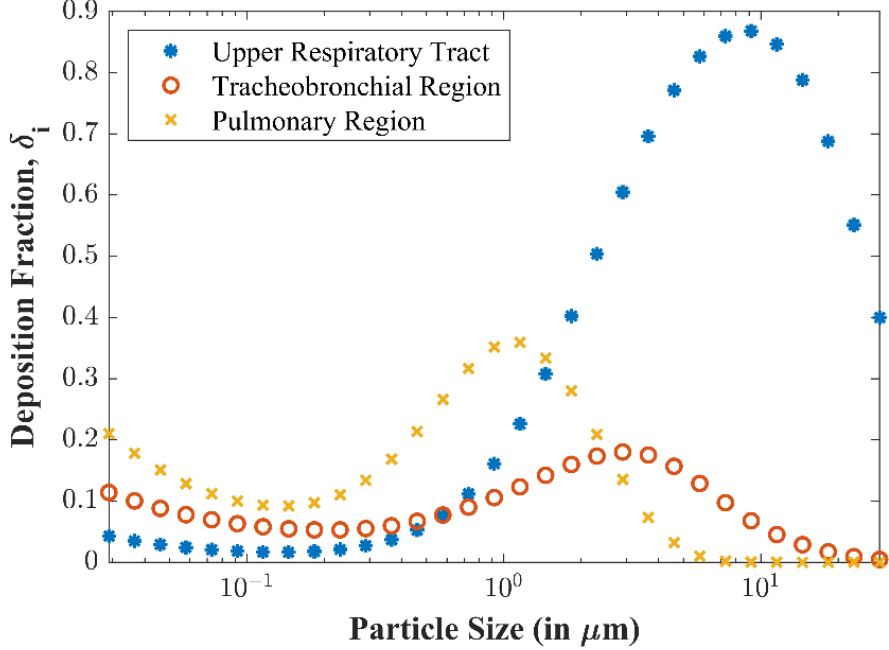
Figure 7 . Deposition fractions ( 𝛿